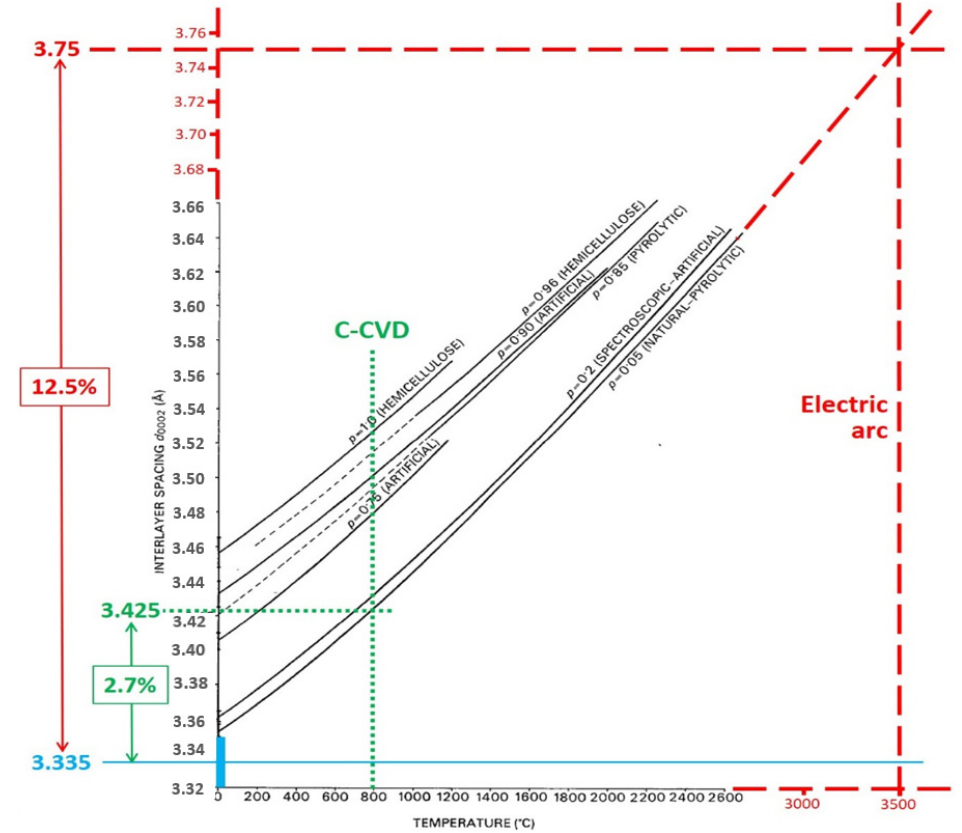
Figure 8. Plot of the variation of the intershell spacing (in Angström) with temperature for a variety of graphenic materials extensively modified from [34]. Several elements have been added to the original figure, in particular all the dotted and dashed lines, and the related labels (coloured in the online version). The thick blue segment at the bottom of the y axis represents the range of most frequent intergraphene spacings in MWCNTs at room temperature, regardless of the synthesis procedure [37], from which we considered the median value (0.3335 nm). Dashed lines (in red) and related labels relate to the electric arc synthesis; dotted lines (in green) and related labels relate to the CCVD synthesis.